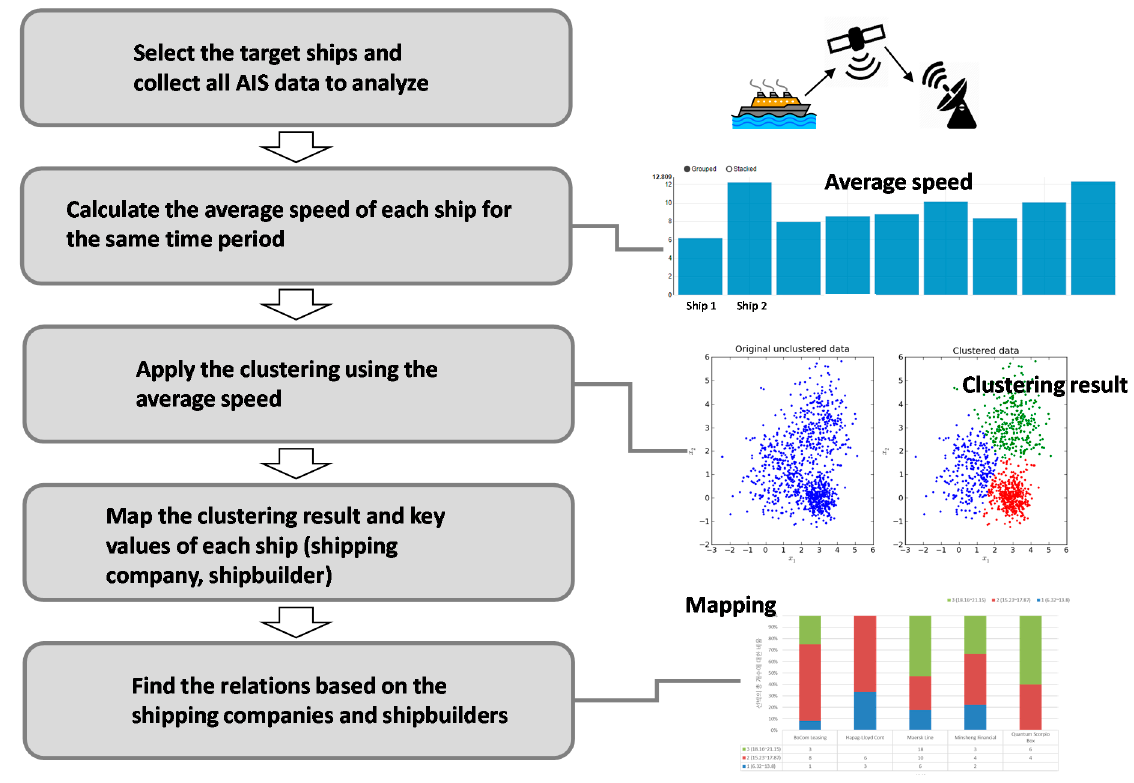
Figure 11. Process of the ship’s speed pattern analysis by shipping companies and shipbuilders.